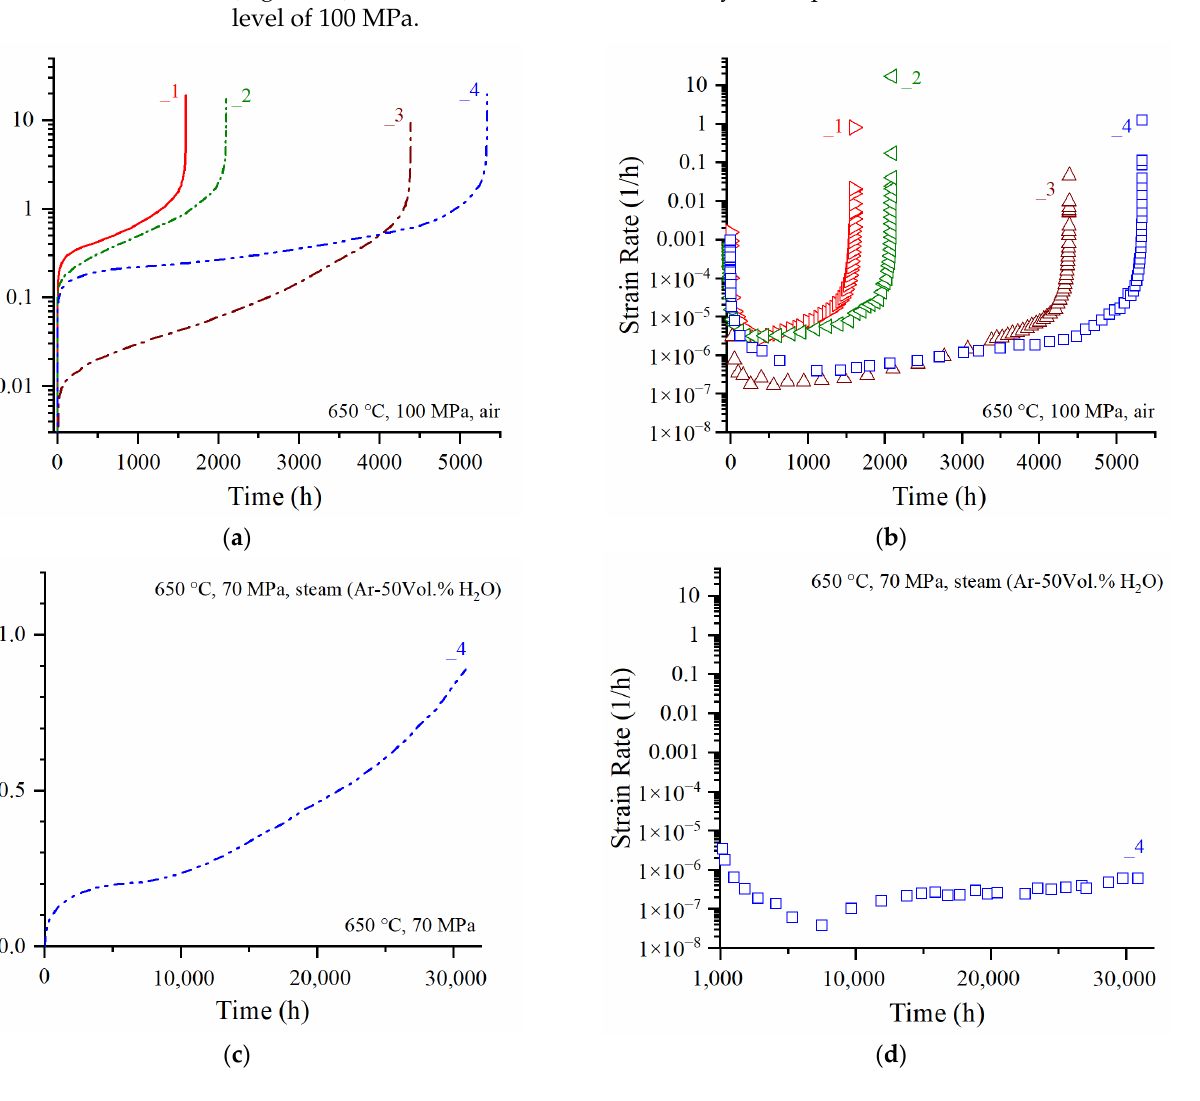
Figure 4. Typical 650 °C creep and creep rate curves of differently rolled HiperFer trial steel: ( a , b ) 100 MPa (air), ( c , d ) 70 MPa (simulated steam: Argon ‐ 50 Vol.% H 2 O). ( a , b ) 100 MPa (air), ( c , d ) 70 MPa (simulated steam: Argon-50 Vol.% H 2